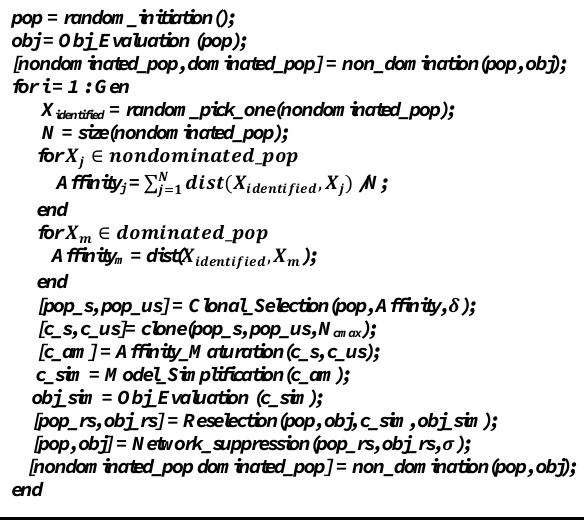
Fig. 5. Pseudo-code of PAIA for